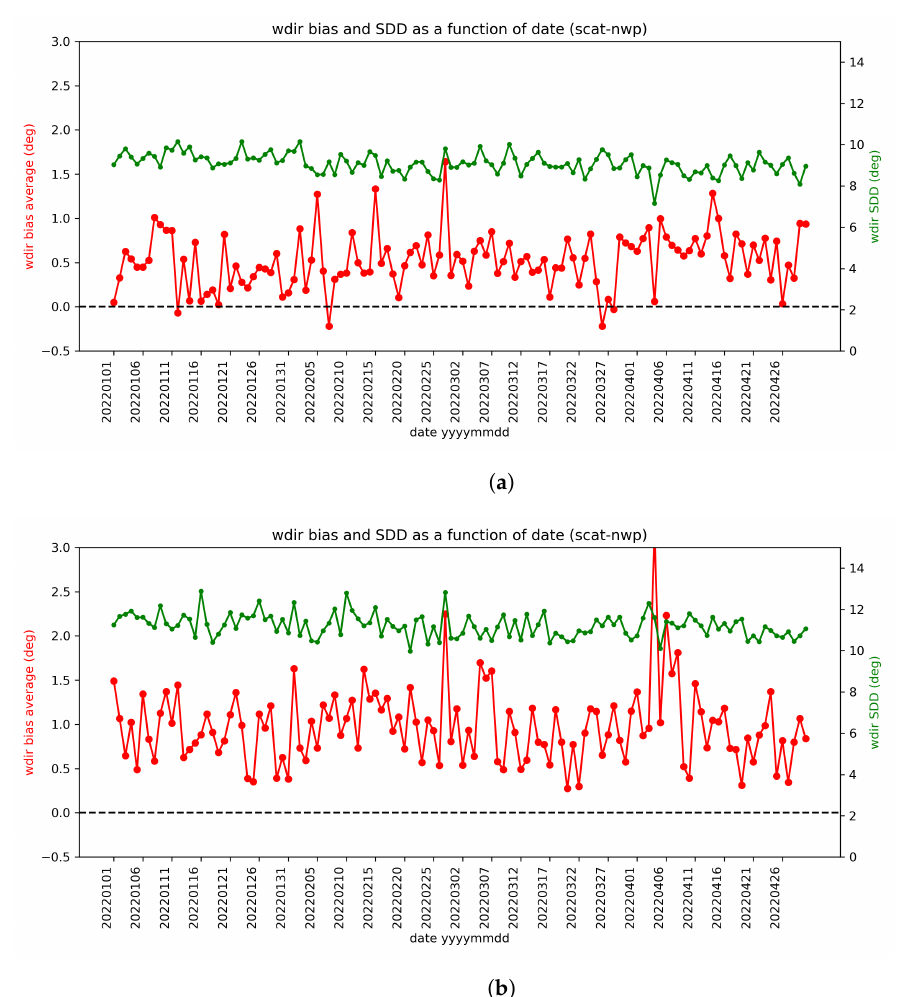
Figure 20. Wind direction bias and its SDD as a function of date (with NOCant+), from 1 January to 30 April 2022: ( a ) Ku-band, ( b )